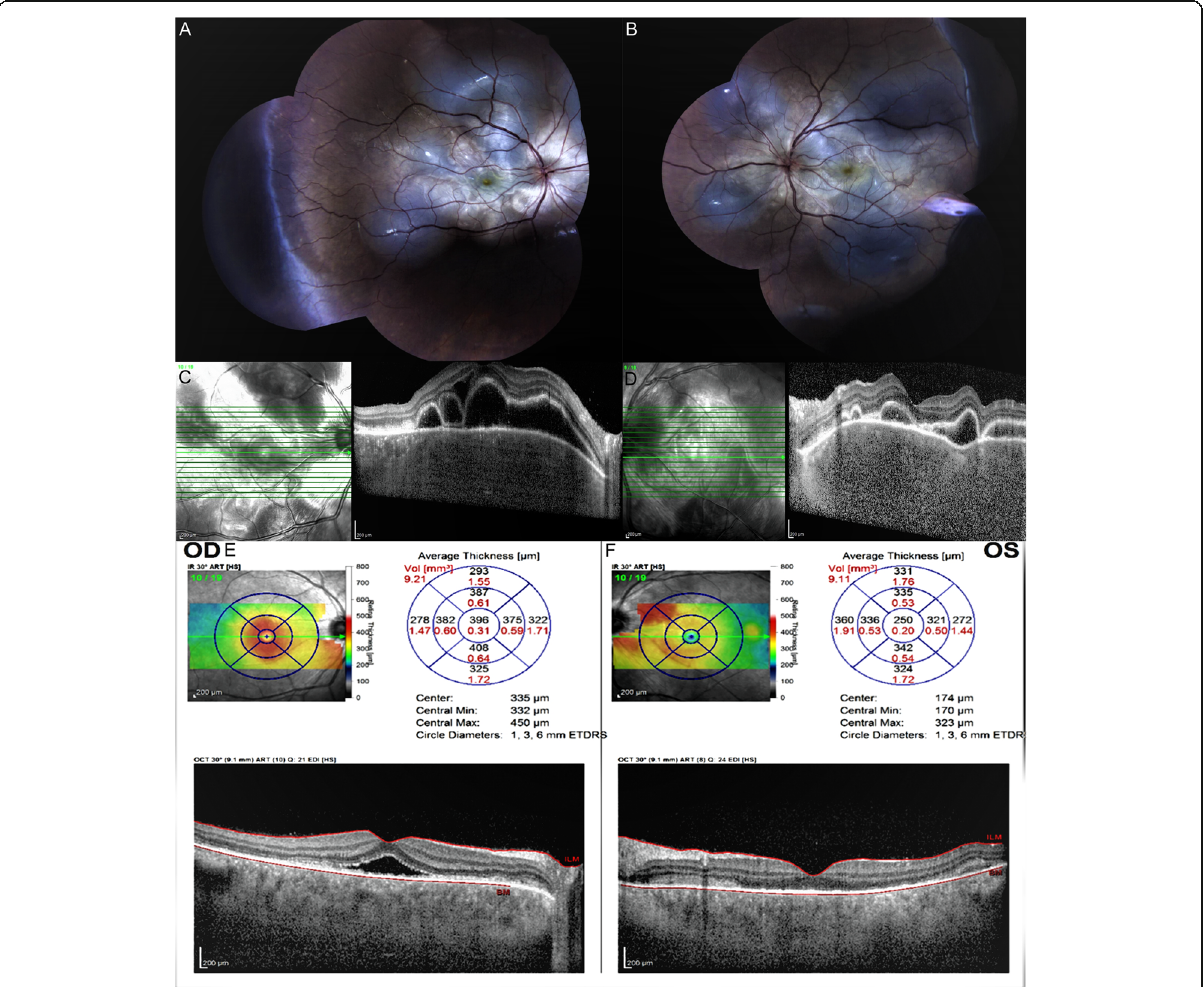
Fig. 1 Fundus photography of the right ( a ) and the left ( b ) eye reveals bilateral disc swelling and multifocal serous retinal detachment at the posterior pole. Enhanced depth imaging optical coherent tomography (EDI-OCT) of the right ( c ) and the left ( d ) eye at the first presentation after the development of sympathetic ophthalmia (SO) discloses multi-lobular serous retinal detachment, septate subretinal spaces, hyperreflective dots in subretinal fluid, choroidal thickening, and undulation of the retinal pigment epithelium. The results of EDI-OCT of the right ( e ) and left ( f ) eye shows the significant response with resolution of serous retinal detachment and decreased choroidal thickening 5days after pulse corticosteroid